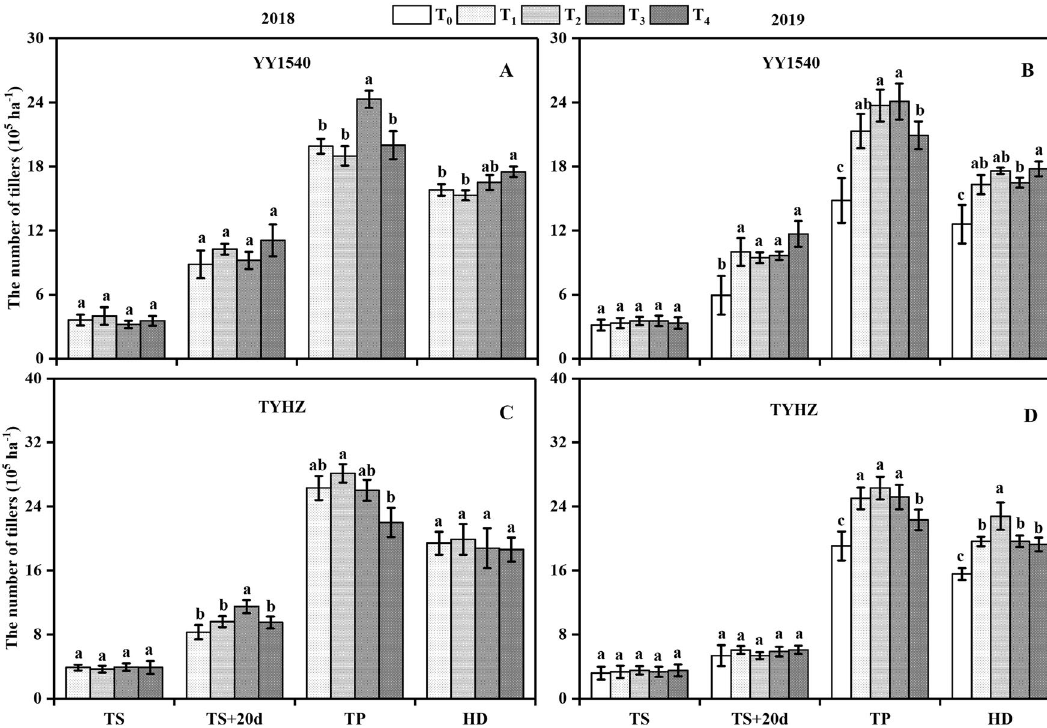
Figure 1. Number of tillers of indica–japonica hybrid rice (‘Yongyou1540’, YY1540) and indica hybrid rice (‘Tianyouhuazhan’, TYHZ) at four developmental stages under four nitrogen fertilization treatments. ( A ) YY1540 in 2018; ( B ) YY1540 in 2019; ( C ) TYHZ in 2018; ( D ) TYHZ in 2019. Bars with lower-case letters are significantly different at the 0.05 probability level among treatments. TS transplanting stage, TS + 20d 20 days after transplanting, TP tillering peak stage, HD panicle heading stage.